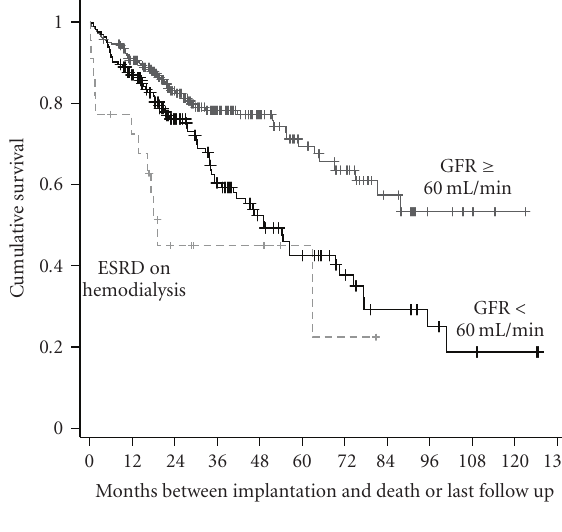
Figure 1: Kaplan-Meier (K-M) survival analysis based on stages of kidney dysfunction. The Log Rank statistic for the K-M Survival analysis was 25.71 ( P < . 00005). For patients with GFR < 60mL/min ( n = 162), mean survival time ( ± SE) was 60 . 3 ± 4 . 7 months (CI 51.0, 69.5) and median survival time was 49 . 2 ± 5 . 8 months (CI 37.7, 60.7). For patients with GFR ≥ 60 mL/min ( n = 257), mean survival was 85 . 9 ± 4 . 3 months (CI 77.4, 94.3); since survival rate did not drop below 50% during the observation period, no median could be calculated. For ESRD patients on hemodialysis ( n = 22), mean survival was 37 . 8 ± 7 . 7 months (CI 22.8, 52.8) and median survival was 19 . 1 ± 1 . 8 (CI 15.6,